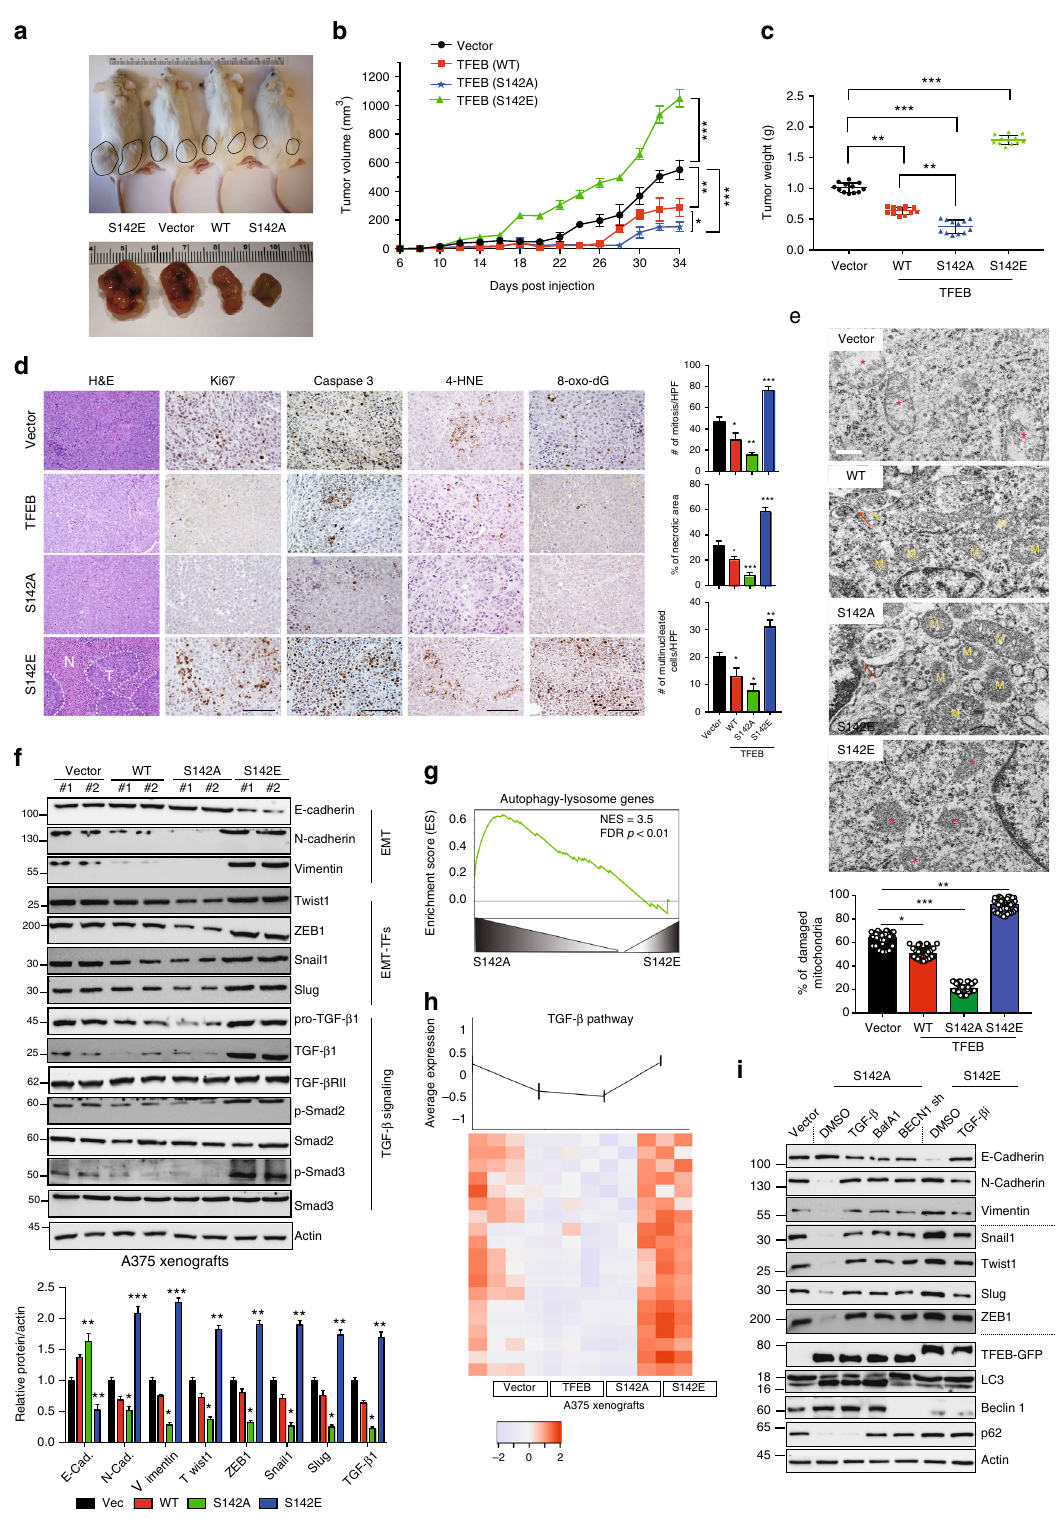
Autophagy – lysosomal inhibition promotes tumor metastasis . To investigate whether blocking BRAFi-induced autophagy – therapy, we used TFEB KD A375 cells reconstituted with WT or mutant TFEB (Fig. 8a). As expected, TFEB KD inhibited PLX4720-induced autophagy – lysosomal activation, which was restored by re-expression of shRNA-resistant WT and